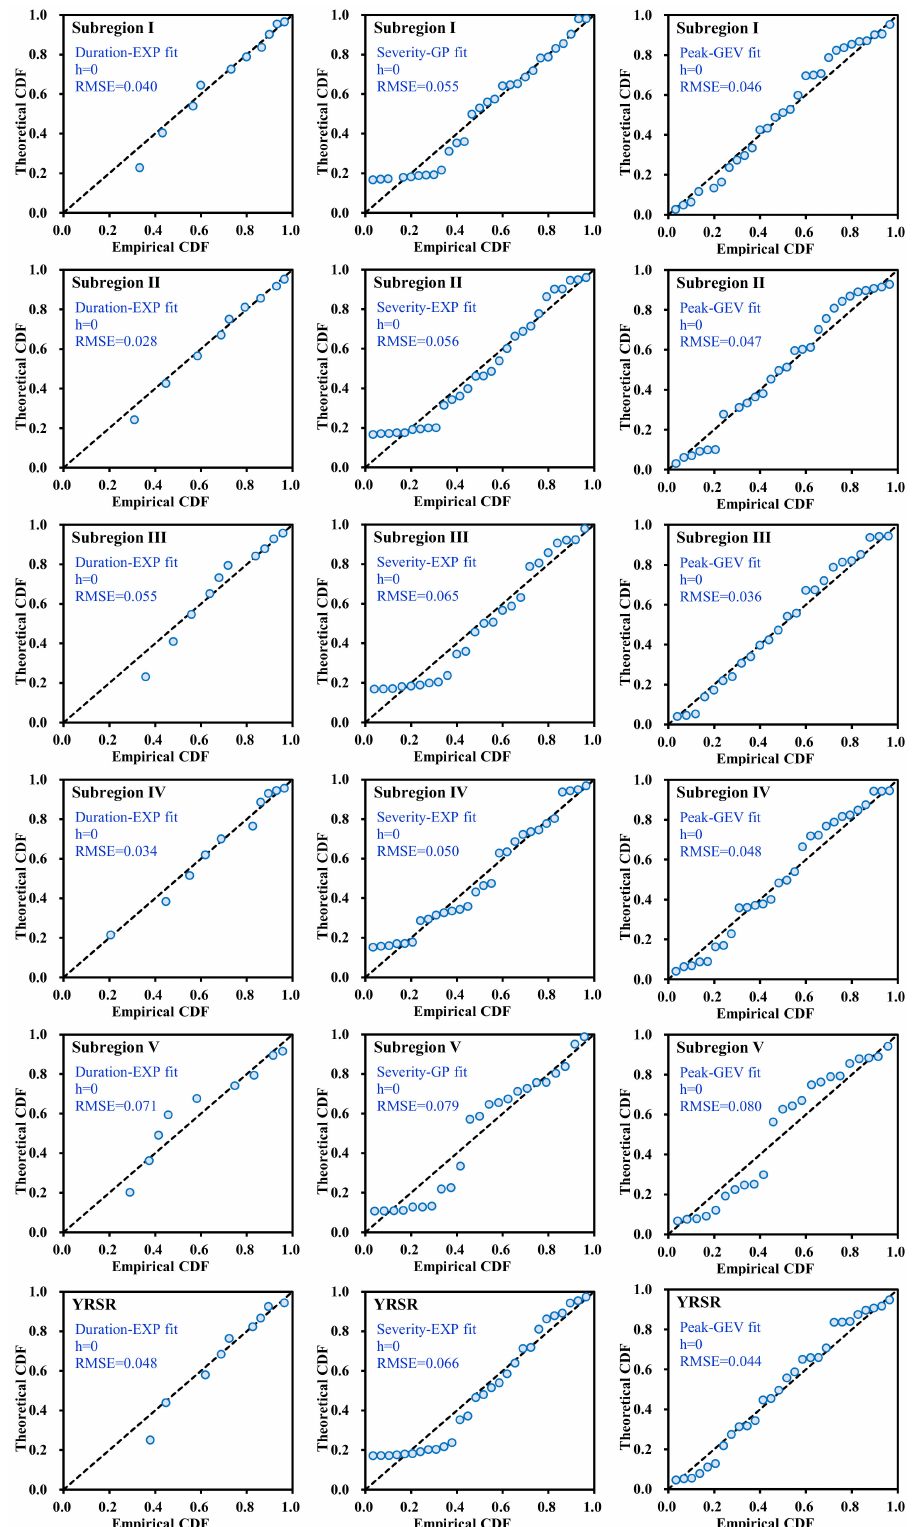
Figure 12. Comparison between empirical and theoretical CDFs of drought duration, severity, and peak in subregions I–V and entire YRSR. EXP, WBL, GP, GEV, and GAM are abbreviations for Exponential, Weibull, Generalized Pareto, Gamma, and Generalized Extreme Value distributions. The value of h is 1 if the test rejects the null hypothesis at the 5% significance level, or 0 otherwise. RMSE is the value of root-mean-square error. The dotted line indicates the 1:1